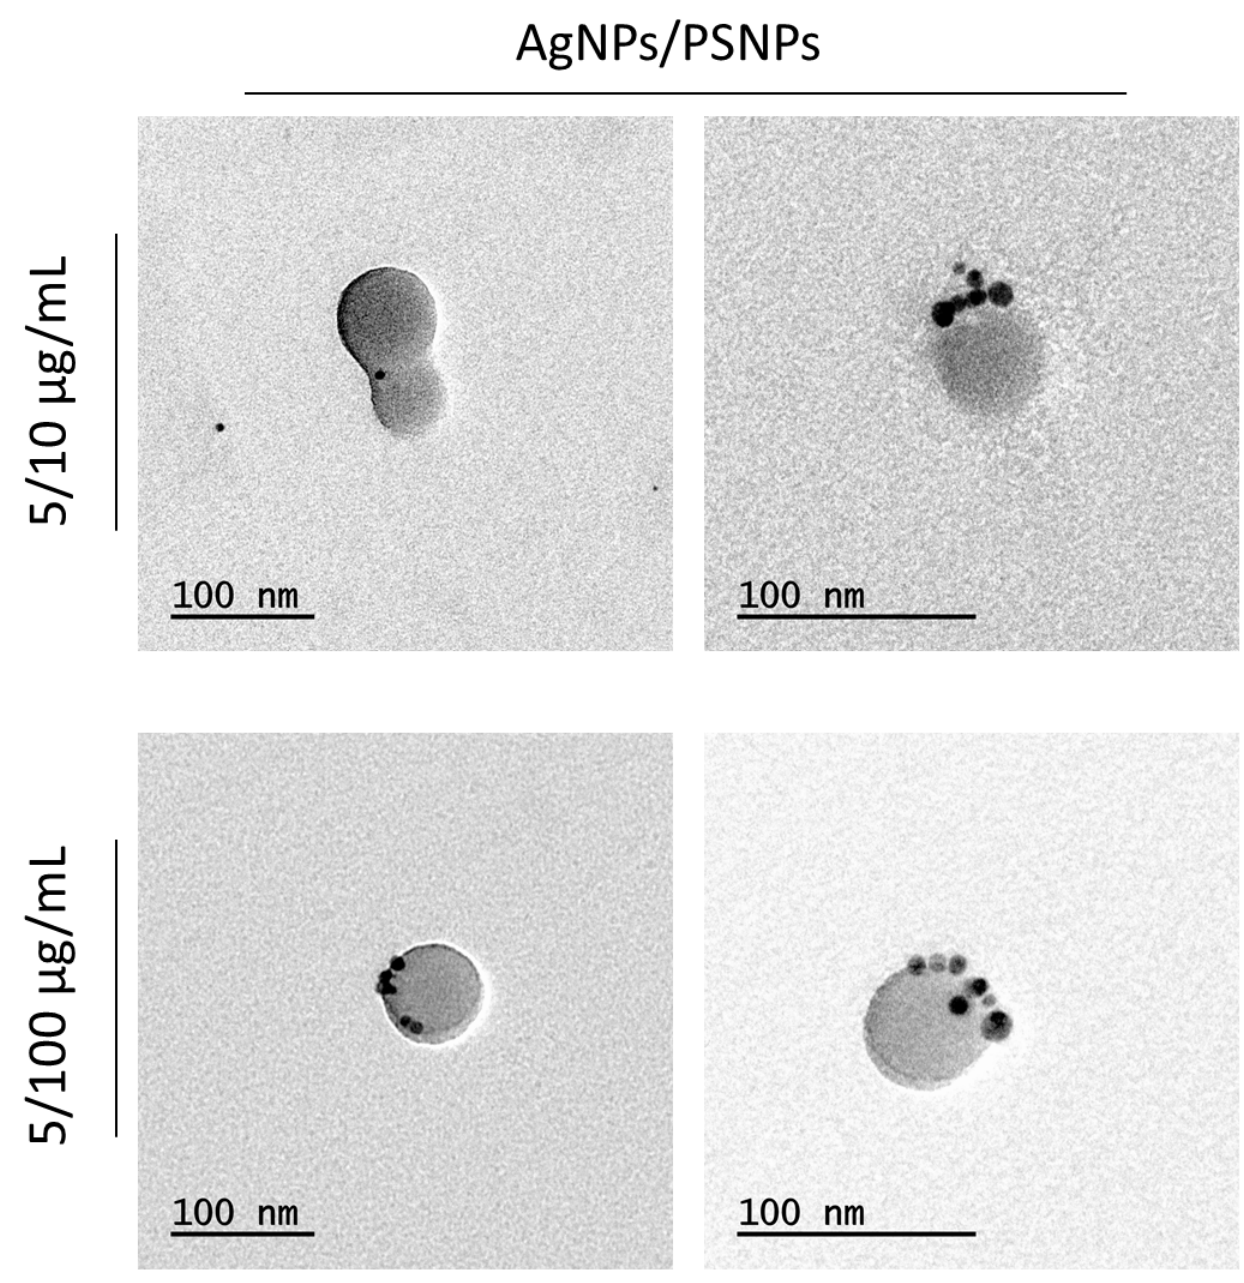
Figure 2. Representative transmission electron microscopy (TEM) images of 5 µ g/mL AgNPs mixed with 10 and 100 µ g/mL PSNPs. The visualized co-treatments are indicated in the Figure as 5/10 or 5/100 µ g/mL.